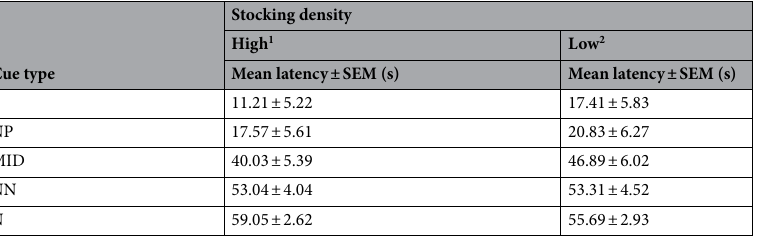
Table 1. Mean (± SEM) latency to approach (s) all cues (positive, P; near positive, NP; middle, MID; near neutral, NN; and neutral, N) of birds from both high- and low-density pens in the judgement bias test for 4